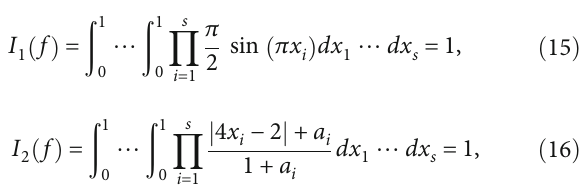
Table 2: Estimates of I Generator